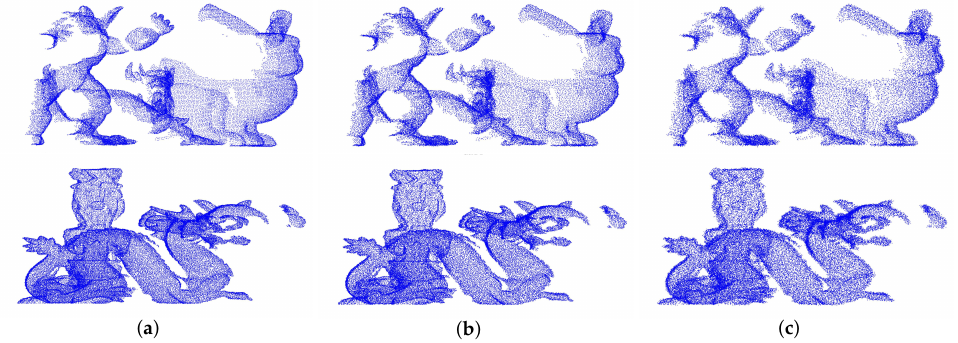
Figure 8. Examples of the scenes with different peak intensity of Gaussian noise. ( a ) 0.05 r. ( b ) 0.1 r. ( c ) 0.2